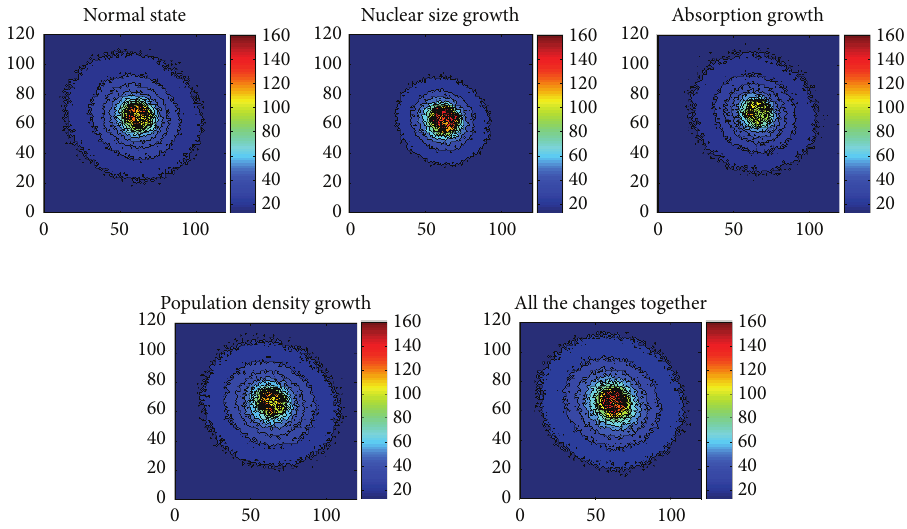
Figure 3: Processed matrices of the Monte Carlo simulated surface backscattered laser light at 15 threshold